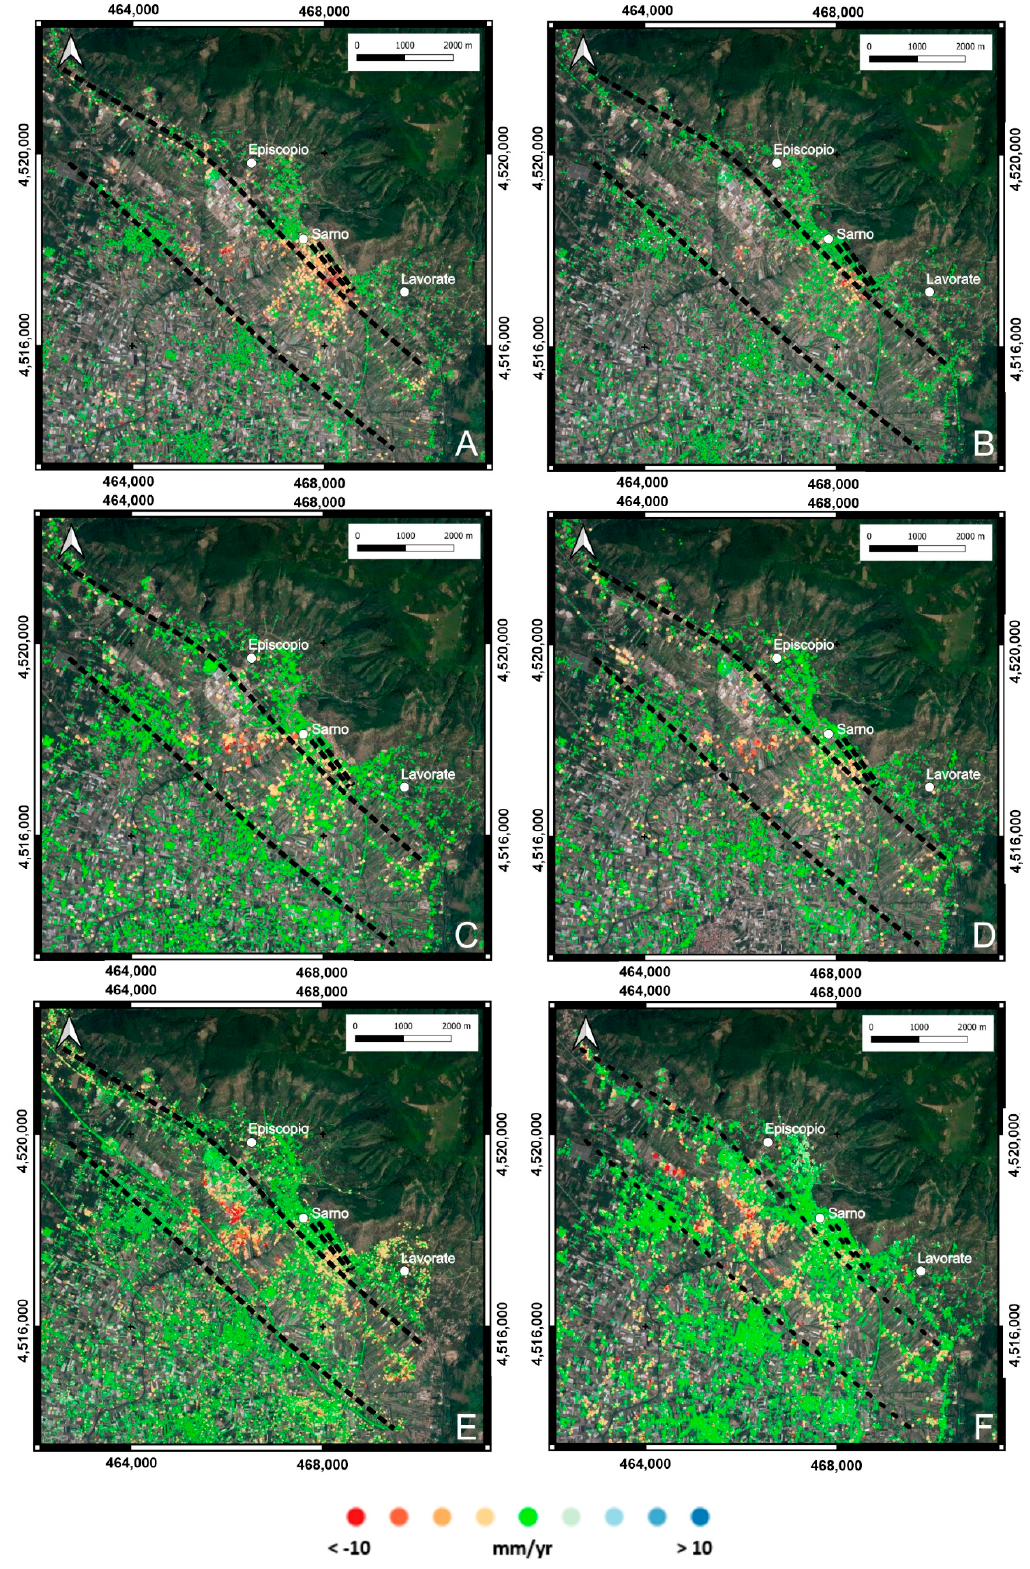
Figure 10. Mean displacement rate maps for: ERS1/2, ( A ) ascending and ( B ) descending; ENVISAT: ( C ) ascending and ( D ) descending; ( E ) Cosmo-SkyMed images in descending orbit; and ( F ) SENTINEL-1 images in descending orbit (2016–2020 time span). Dashed black lines indicate faults inferred by geomorphological and stratigraphic analysis (see Figure